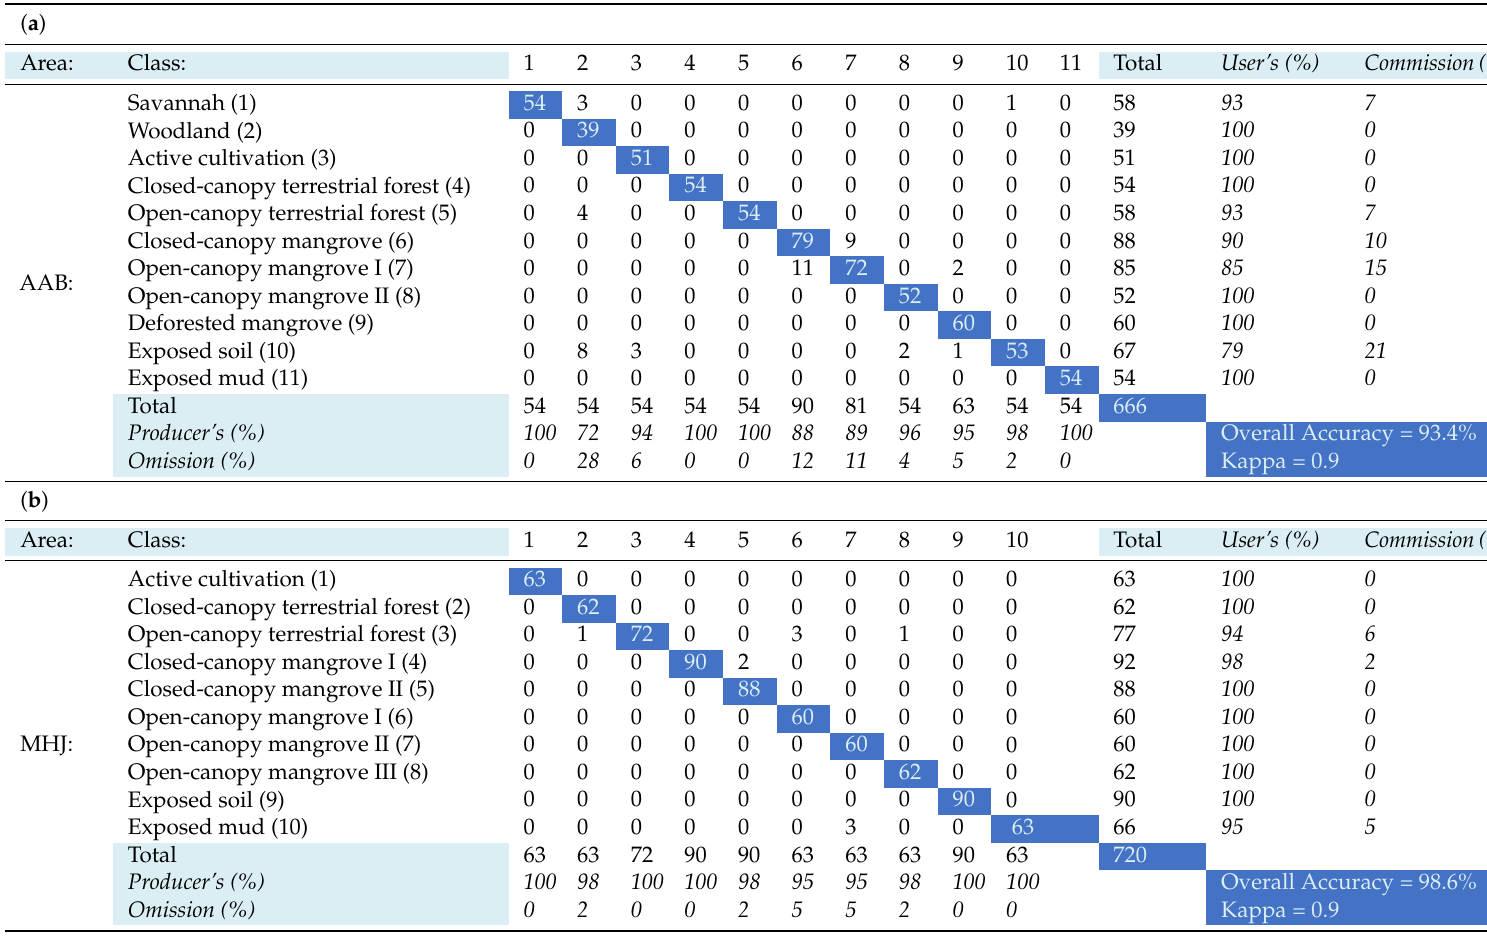
Table 4. ( a – d ) Classification accuracies, including overall accuracies, Kappa statistics and per-class user’s and producer’s accuracies. Results for AAB and MHJ were previously reported in Jones et al. [25] and Jones et al.